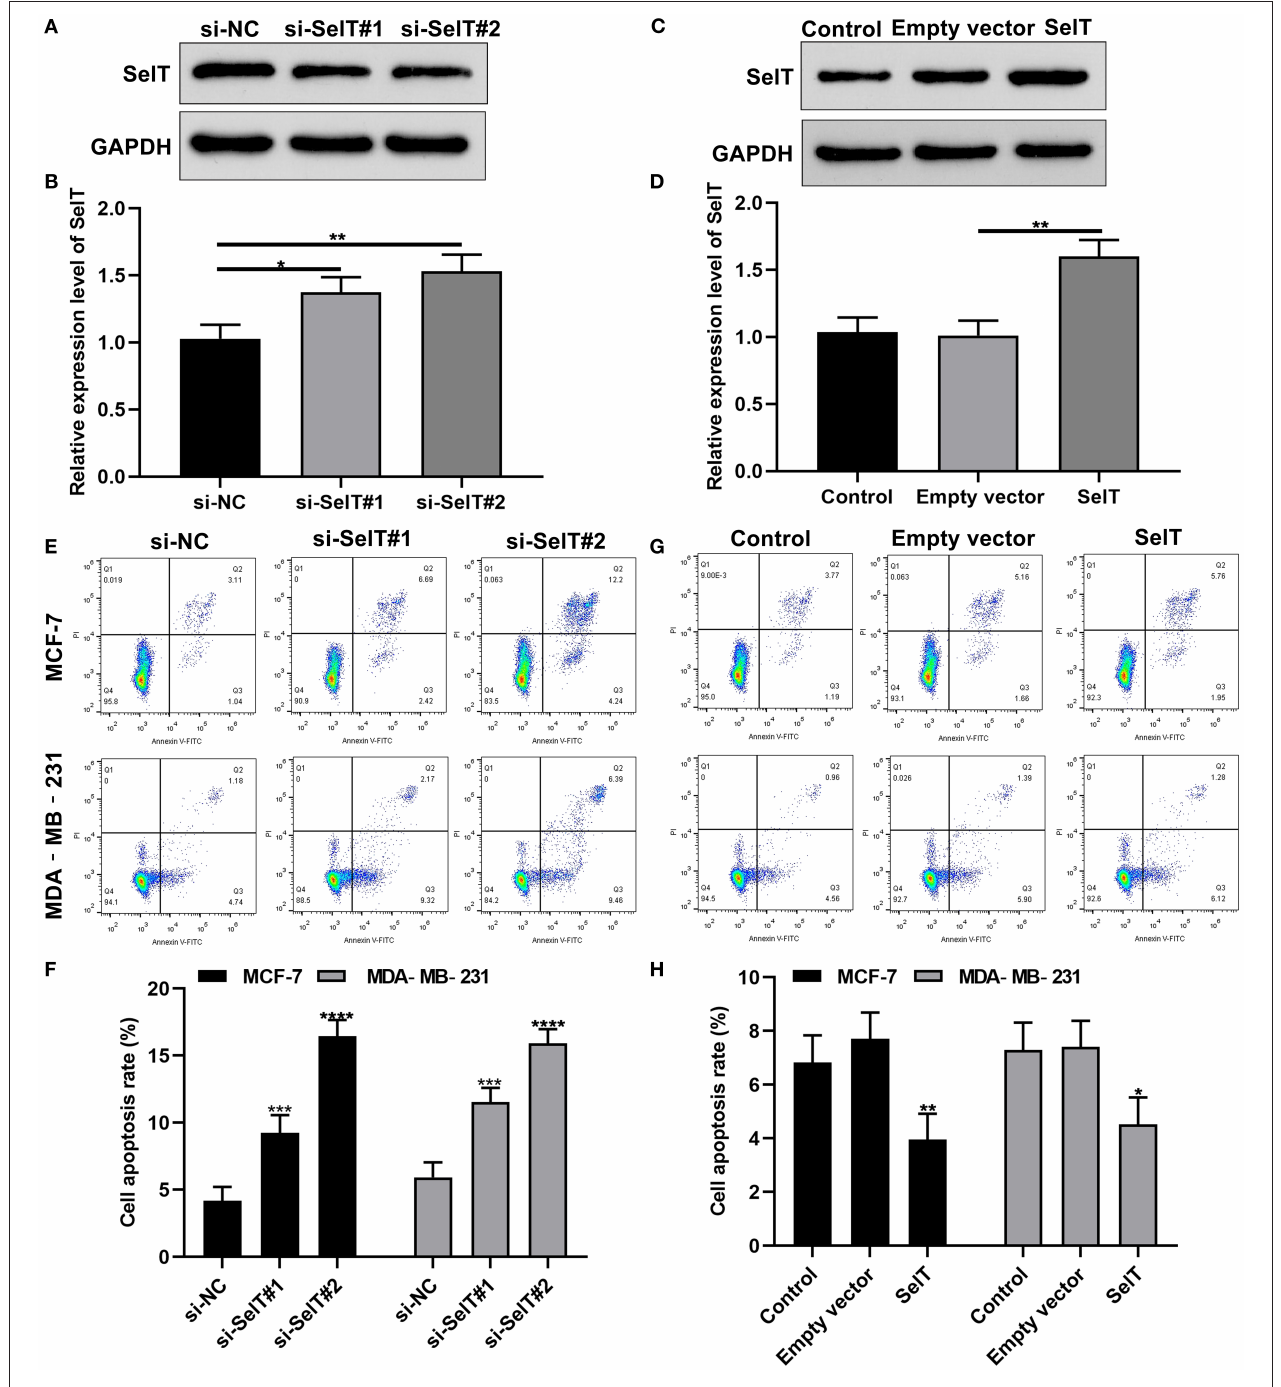
FIGURE 4 | Inhibition of SelT promotes the apoptosis of breast cancer cells. (A,B) Western blot for the expression of SelT in breast cancer cells transfected with si-SelT#1 and si-SelT#2. (C,D) Validation of SelT expression in breast cancer cells transfected with SelT by western blot. (E,F) Flow cytometry assay for apoptotic levels of MCF-7 as well as MDA-MB-231 cells transfected by si-SelT#1 and si-SelT#2. (G,H) Assessment of breast carcinoma cell apoptosis under SelT overexpression. * p < 0.05; ** p < 0.01; *** p < 0.001; **** p < 0.0001.